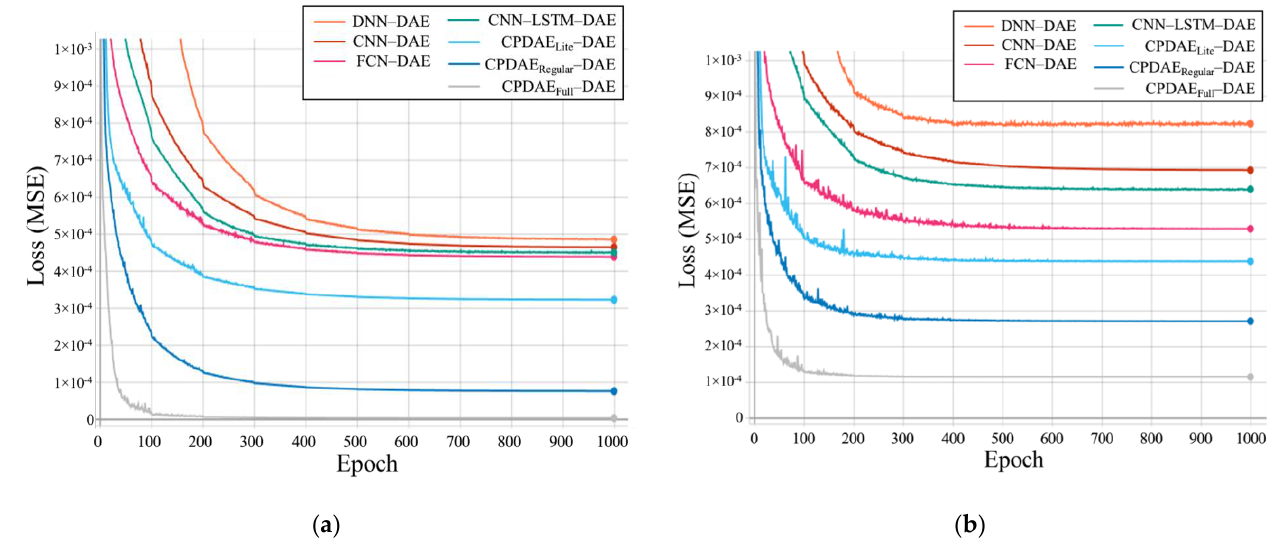
Figure 10. The loss curves in training and testing phases: ( a ) training phase; ( b ) testing phase.